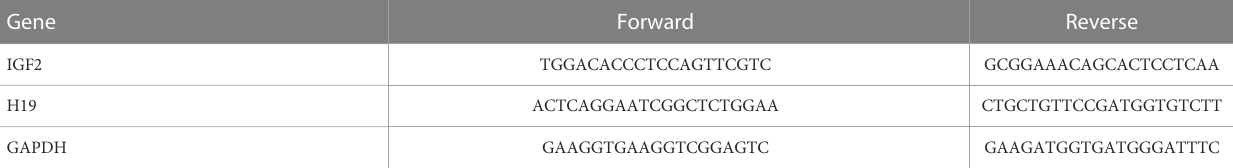
TABLE 3 Primers for real-time quantitative PCR of human blood.